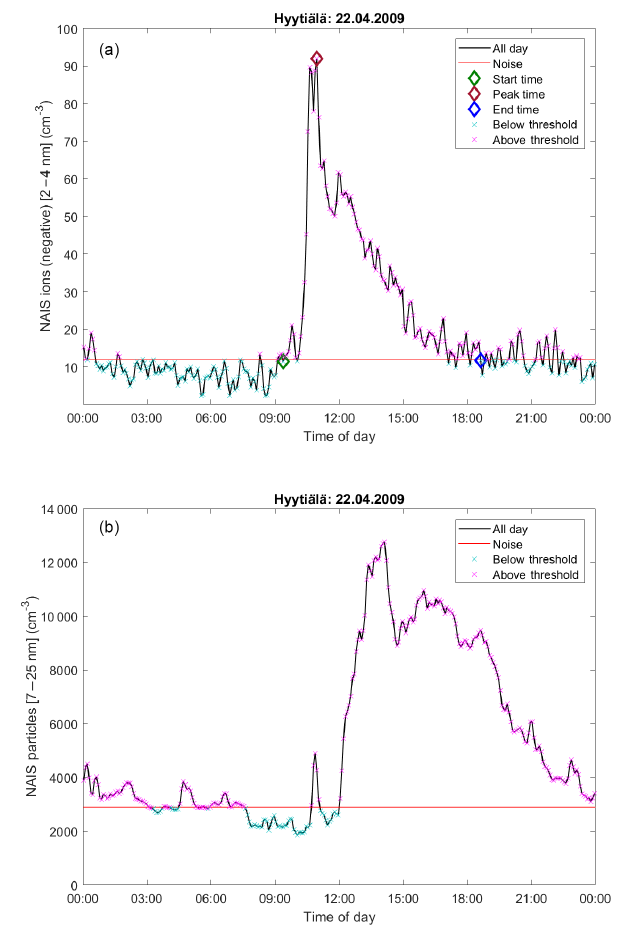
Figure 2. Example of an automatic method applied to (a) 2–4nm ions (negative); ion concentration passed threshold and persisted for more than 1h. (b) Example of 7–25nm particles; particle concen- tration passed threshold and persisted for more than